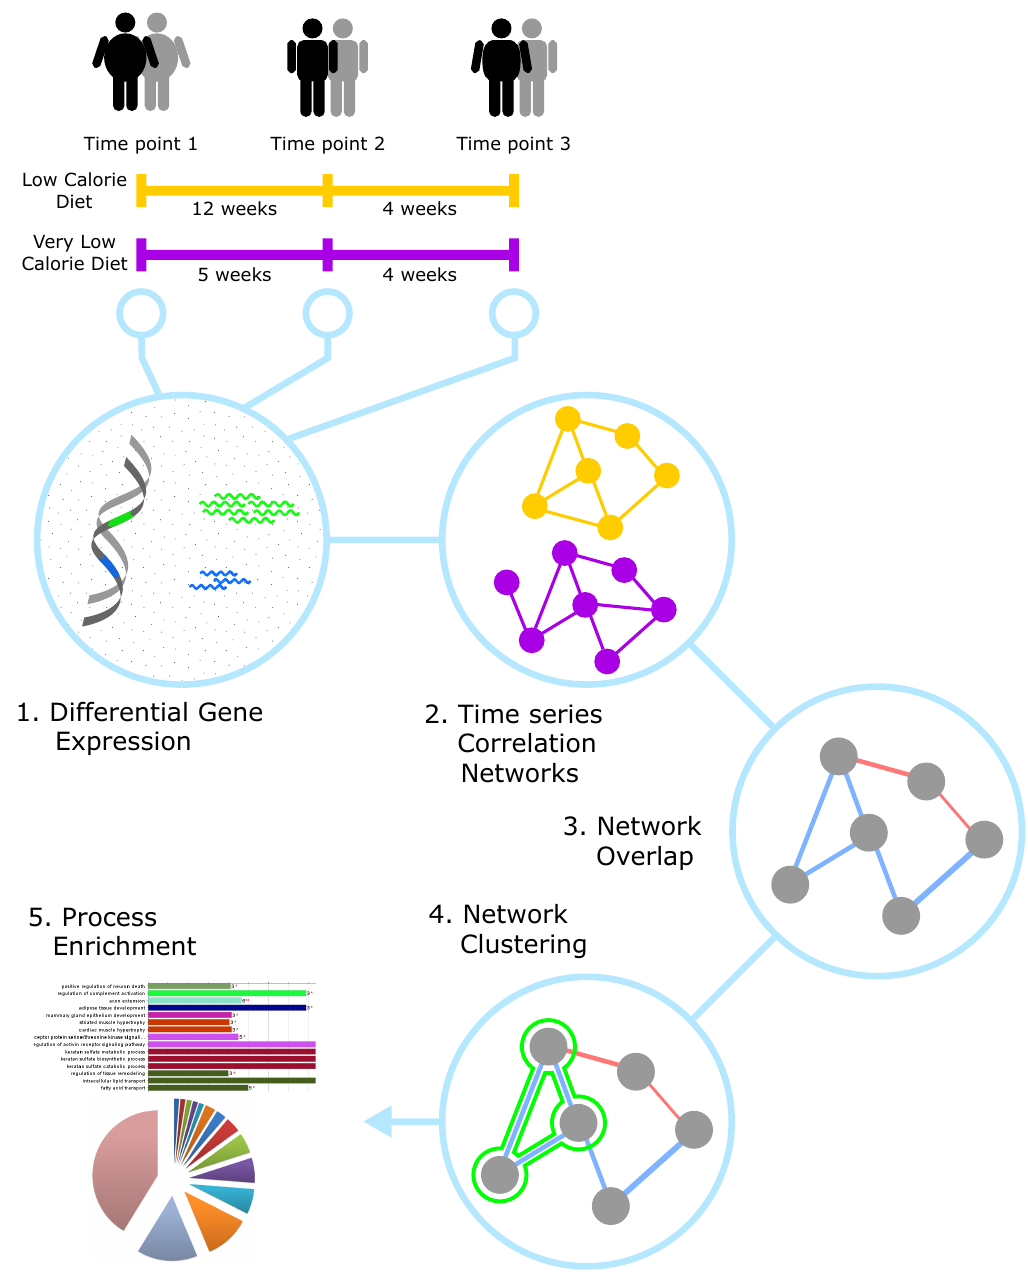
Figure 1. Network biology analysis workflow. ( 1 ) The time series expression data from the time points is normalised and differential expression analysis is performed. ( 2 ) Correlation networks are constructed on the time series for each diet respectively. ( 3 ) The overlap network is generated from the two networks showing the correlations which are shared between the two diets. ( 4 ) Community clustering is performed to find clusters of genes which are showing the most similar expression patterns. ( 5 ) The overlap network and the gene clusters are then used for process enrichment to find the affected cellular